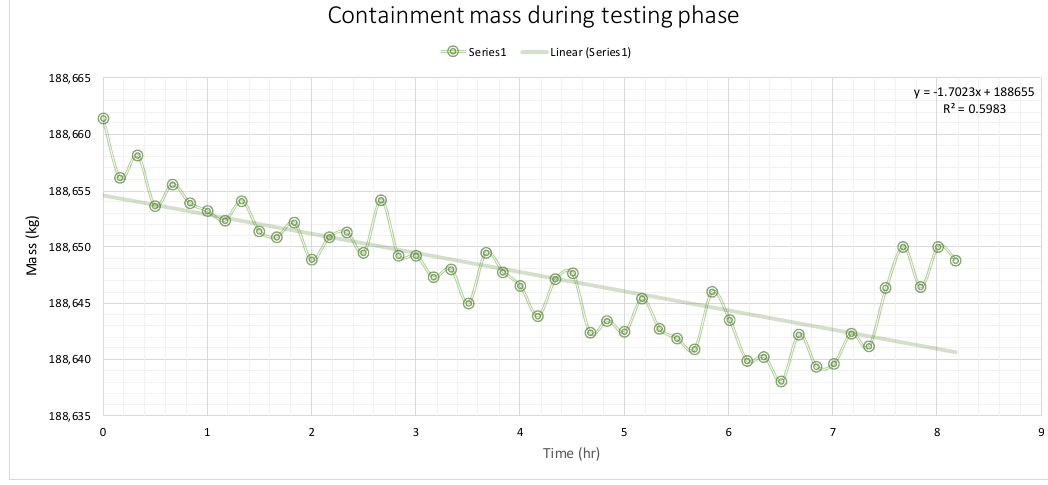
Figure 7. Calculated containment mass (linear fit) based on the testing phase measurement.